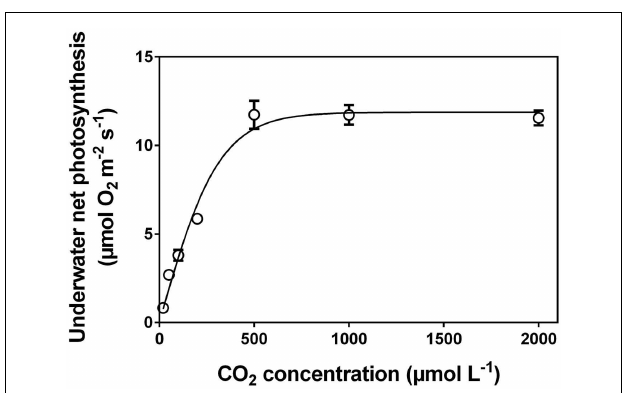
FIGURE 6 | Underwater net photosynthesis versus CO 2 concentration in the medium for excised leaf segments of Hordeum marinum . Leaf segments (30mm) were incubated in 35mL glass vials with various well defined CO 2 concentrations on a rotating wheel with PAR of 350 µ mol photons m − 2 s − 1 at 20˚C (see Figure 1C ). O 2 evolution was measured with a Clark type O 2 microelectrode and underwater net photosynthesis was calculated as O 2 evolution per projected area per unit time (See “The RotatingWheel Incubator”). Data (mean ± SE, n = 5) from (Pedersen et al., 2010). Note: leaves of H. marinum are superhydrophobic and so possess a gas film when